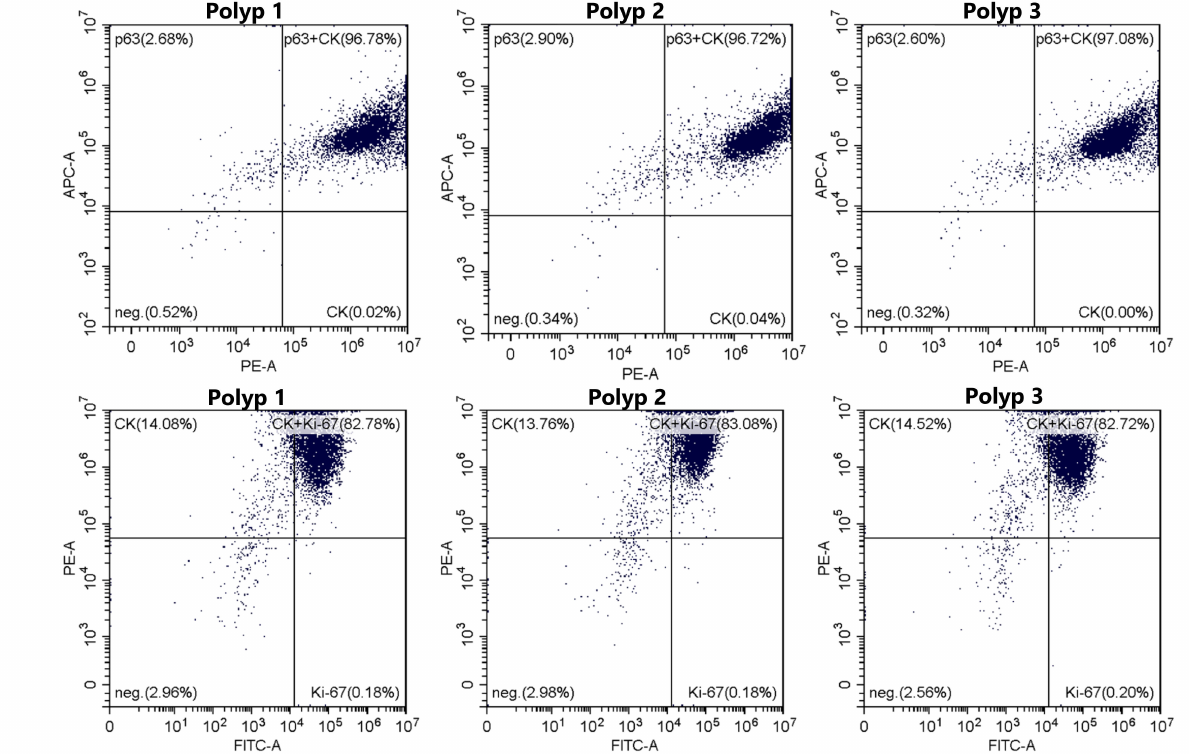
Figure 5. Flow cytometry analysis of cytokeratin, p63, and Ki-67 expression in the isolated cells from 3 tissue samples. ( A ): The relative fluorescence intensity due to CK (PE) and p63 (APC) is plotted on the log scale x- and y-axis, respectively. The proportion of simultaneously positive p63 and CK was 96.86% ± 0.1114%, indicating that the isolated cells are undifferentiated epithelial cells. ( B ): The relative fluorescence intensity due to Ki-67 (FITC) and CK (PE) is plotted on the log scale x- and y-axis, respectively. Most of the cells were Ki-67 positive (82.86% ± 0.1114%) and are, therefore, in a proliferative cell cycle, which reflects good proliferation of the cells. CK: